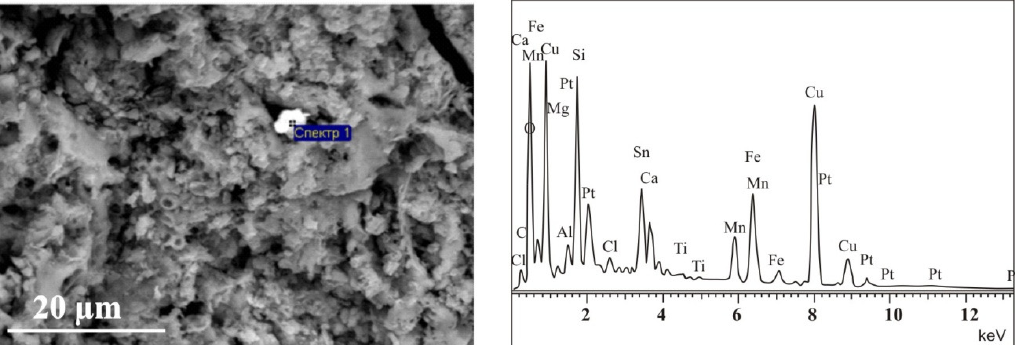
Figure 8. Micrograin copper in the Detroit guyot CMC (platinum plated). Electron microscopic image and EMF spectrum of the composition (platinum deposition).